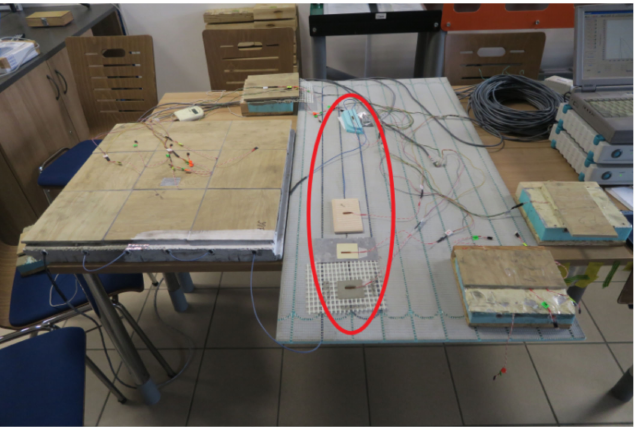
Figure 12. Stand for the correction of component materials in the LFS without